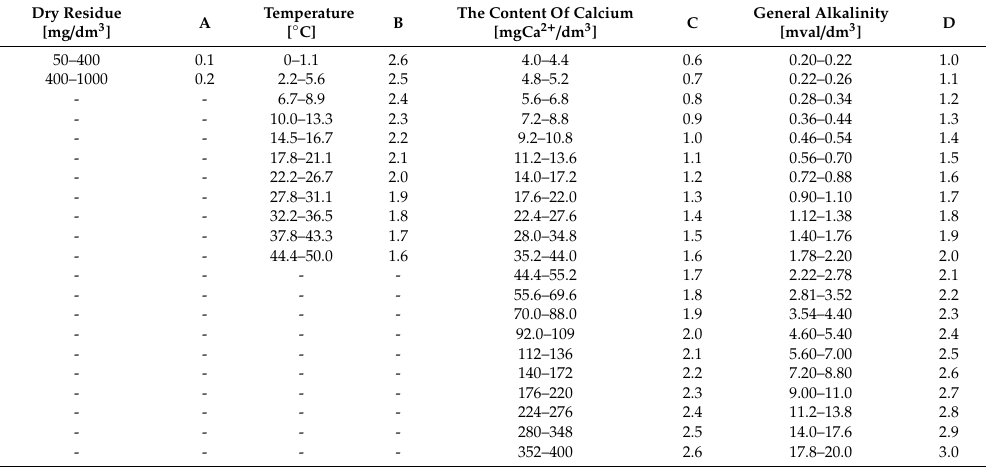
Table A2. Values of A–D coe ffi cients and for calculating pH s .